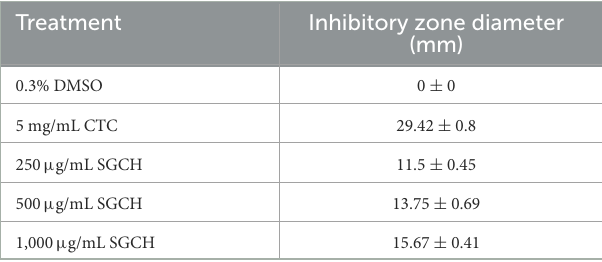
TABLE 1 Inhibitory zone diameter of SGCH at different concentrations against SA .